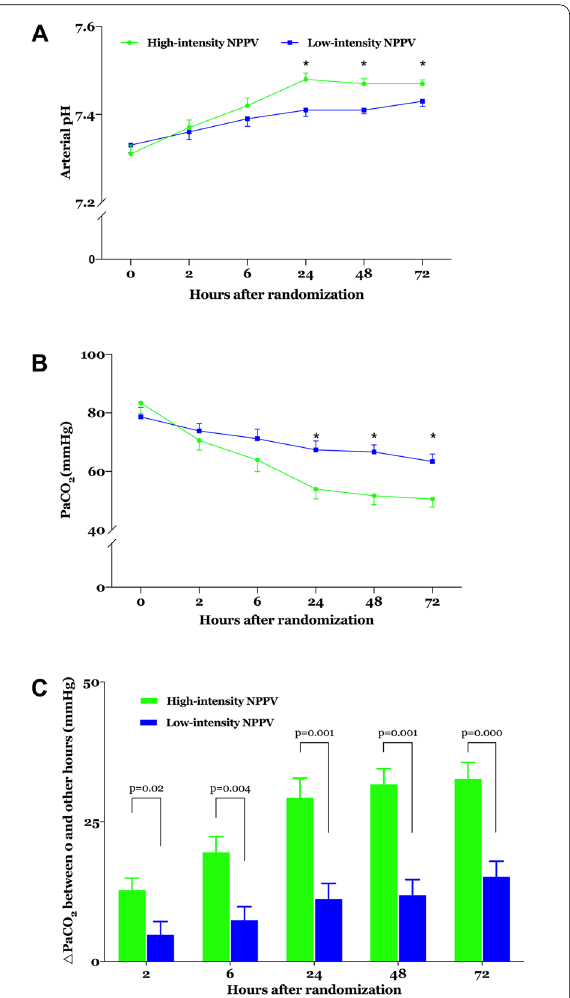
Fig. 3 a pH and b PaCO 2 from baseline through 72 h after randomisation and c differences in PaCO 2 between baseline and other times after randomisation. Values are means and standard errors. * p < 0.05 between the two groups at the same time. NPPV noninvasive positive pressure ventilation, PaCO 2 arterial carbon dioxide